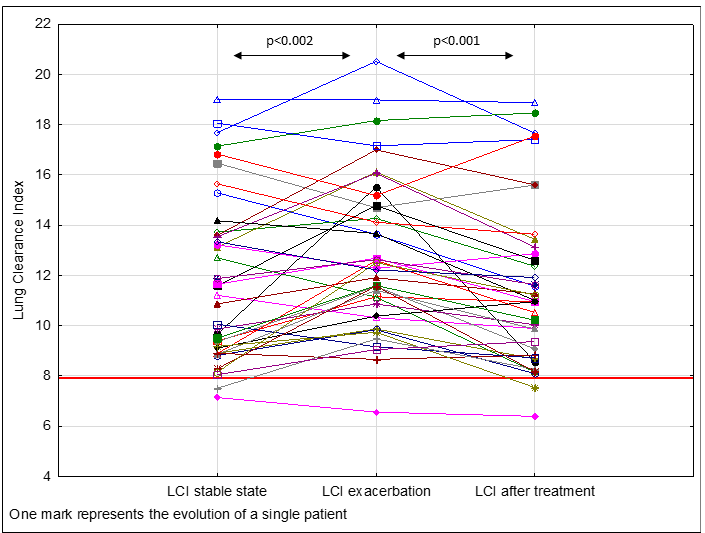
Figure 2. Lung clearance index (LCI) values for CF subjects in stable condition, before and after treatment of pulmonary exacerbation. For LCI, the upper limit of 7.91 was presented according to normative data for healthy children [19].